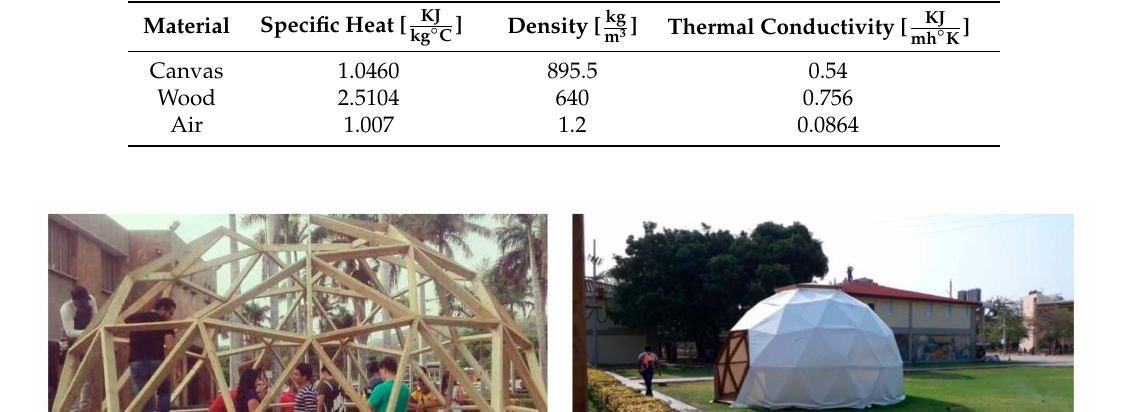
Table 1. Thermal parameters of the geodesic dome.